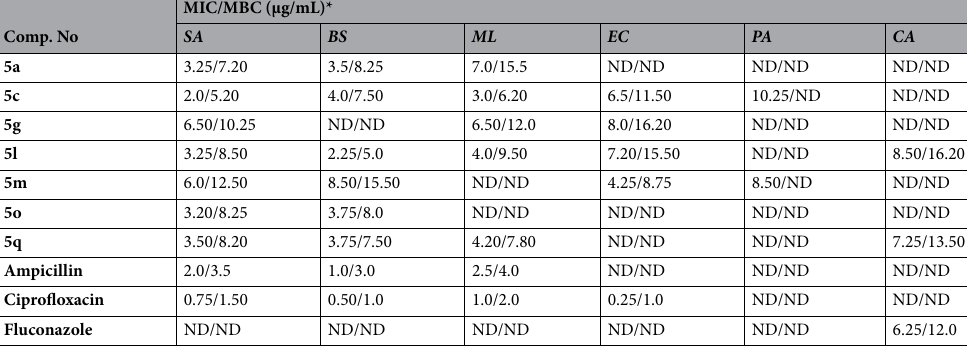
Table 2. The Minimal Inhibitory Concentrations (MIC) and Minimal Biocidal Concentrations (MBC, bactericidal and fungicidal) of compounds 5a , 5c , 5g , 5l , 5m , 5o and 5q in comparison with the broad spectrum antibacterial drugs Ampicillin trihydrate, Ciprofloxacin and the antifungal drug Fluconazole against the Gram-positive bacteria Staphylococcus aureus IFO 3060 ( SA ), Bacillus subtilis IFO 3007 ( BS ) and Micrococcus luteus IFO 3232 ( ML ), the Gram-negative bacteria Escherichia coli IFO 3301 ( EC ) and Pseudomonas aeruginosa IFO 3448 ( PA ) and the pathogenic fungus Candida albicans IFO 0583 ( CA ). ND not determined. *Data shown are the mean values of three experiments.